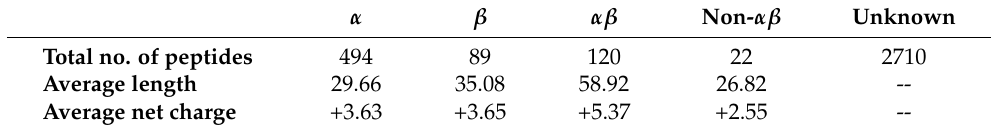
Figure 1. Comparison of the amino acid compositions of four AMP classes ( α , β , αβ , and non- αβ ) based on the 721 records of structurally-annotated natural peptides in the APD3 database. Table 1. Summary of the average length and net charge of the four classes of AMPs in the APD3